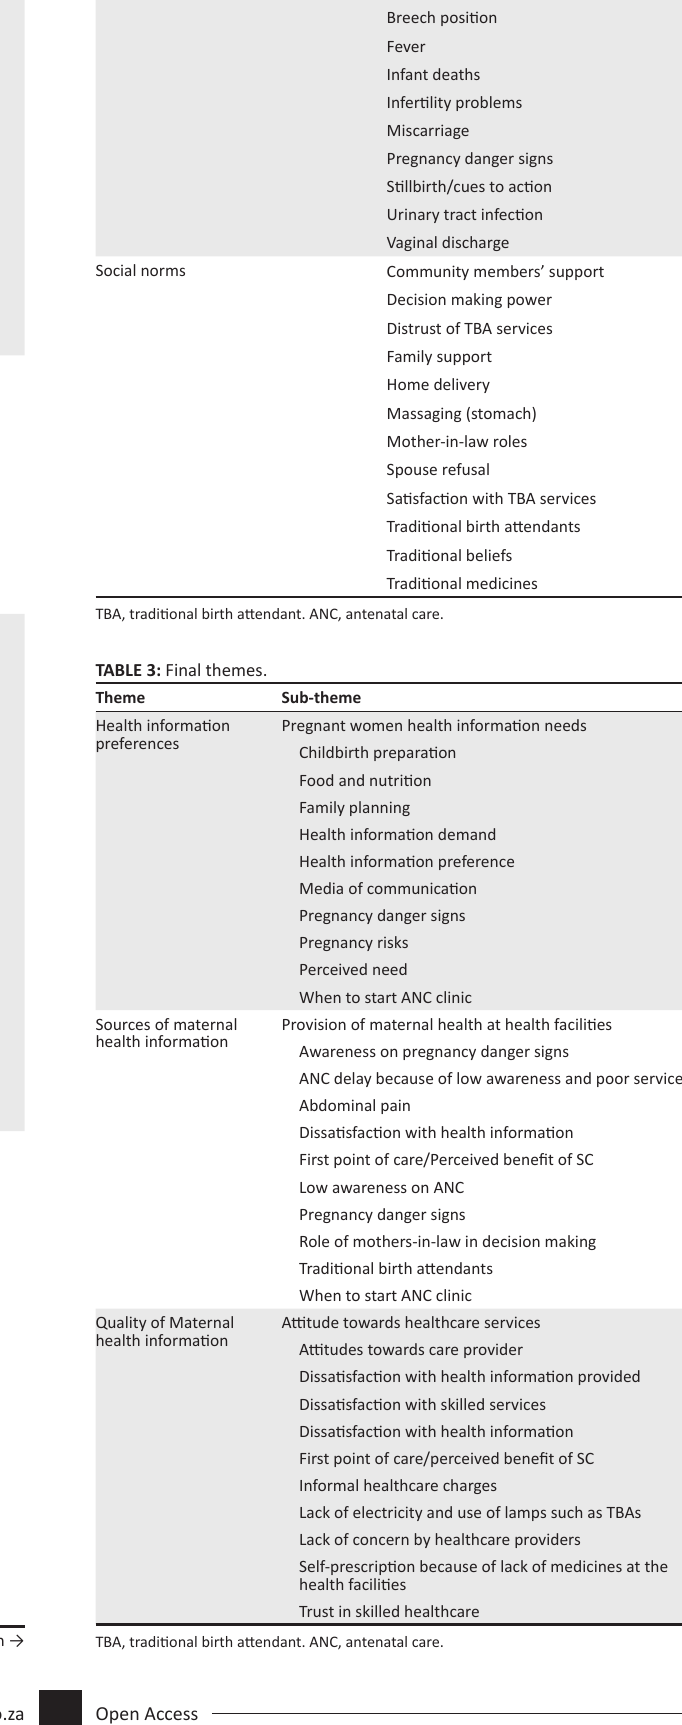
TABLE 2: Preliminary themes. Theme Codes Attitude towards healthcare services